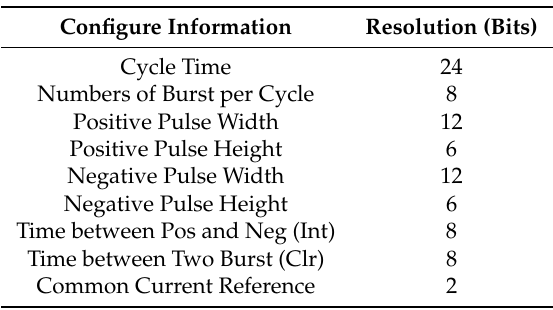
Table 1. Configuration of the on-chip registers for digital control. Pos: positive, Neg: negative, Int: the interval in Figure 4c, Clr: clear